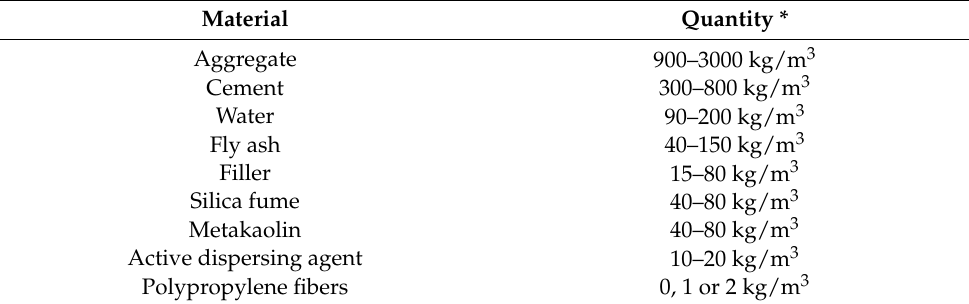
Table 7. High-strength concrete formulation [53].